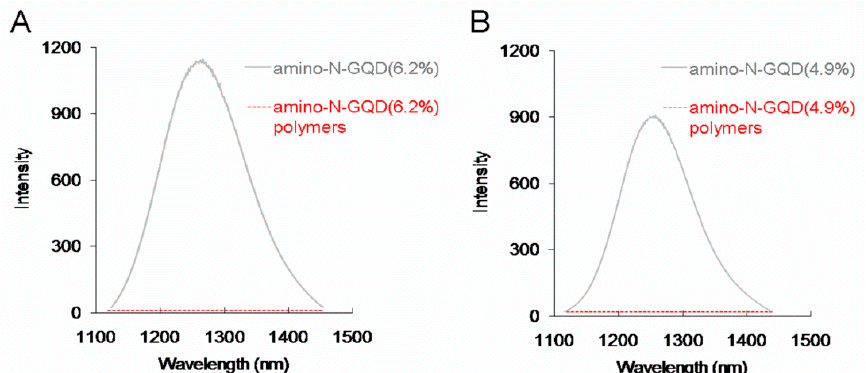
Figure 7. Phosphorescence spectra at 1270 nm for the ( A ) amino-N-GQD (6.2%)- and ( B ) amino-N-GQD (4.9%)-polymers. The delivered dose of the material was 4 µg mL − 1 in ddH 2 O.